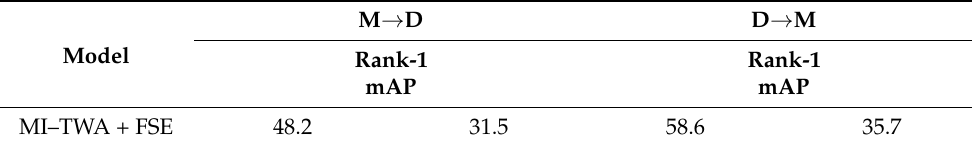
Table 7. Performance of our models on the cross-domain